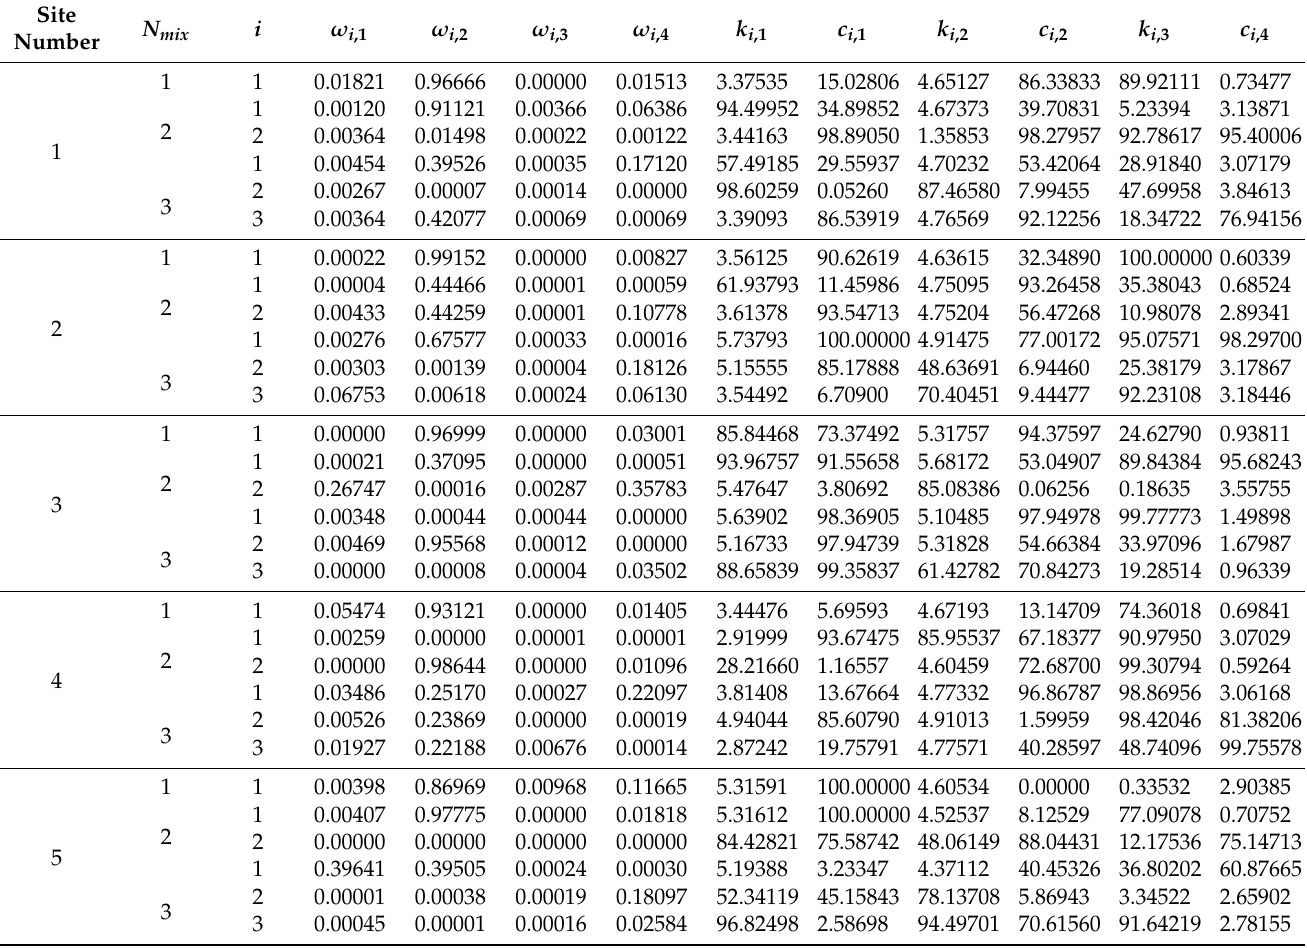
Table 6. Weights and PDFs parameters of f mix for 30 equal wind speed spacings using the MOPSO algorithm.